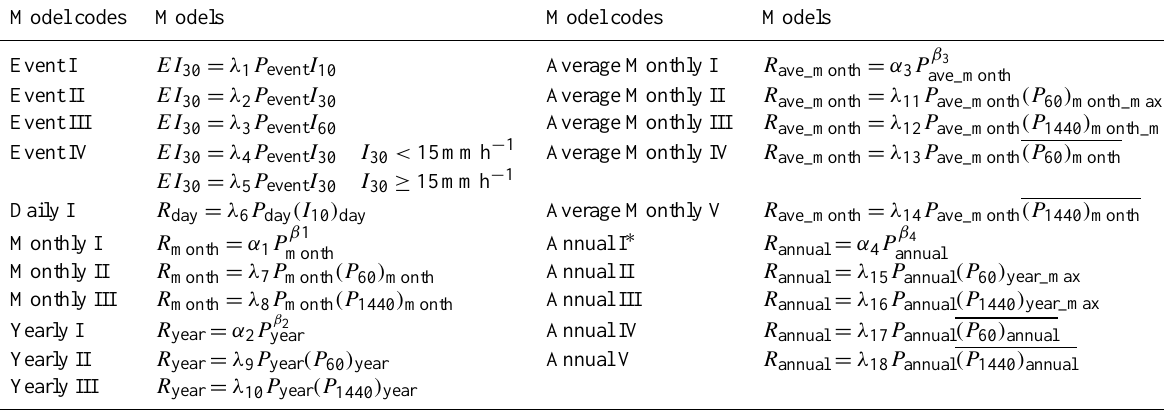
Table 2. Models calibrated.